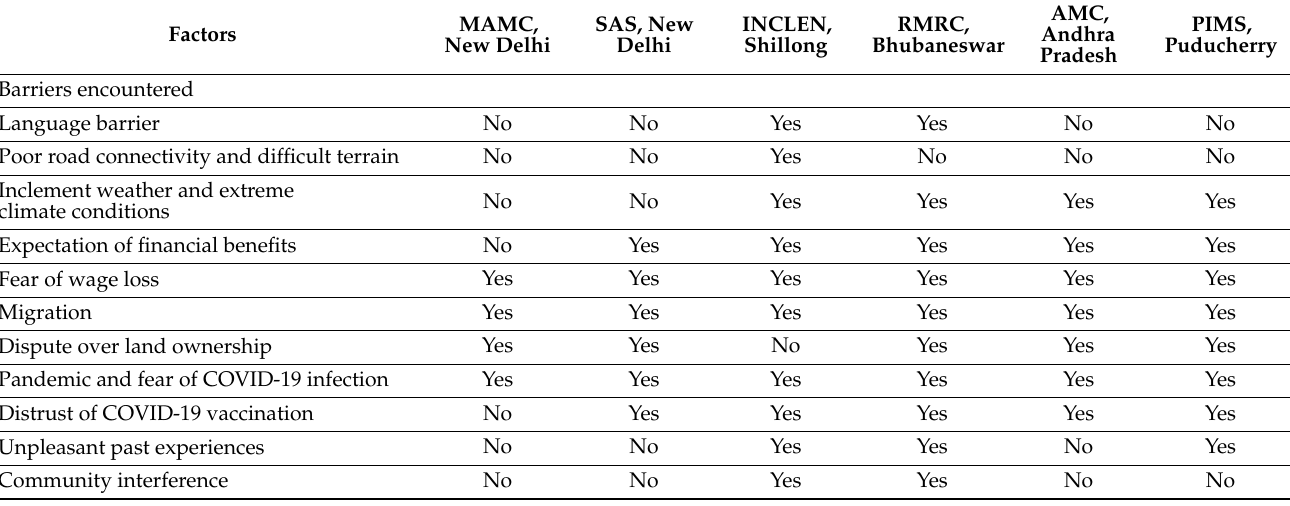
Table 2. DDESS site wise comparison of the barriers, enablers and strategies for achieving enhanced community